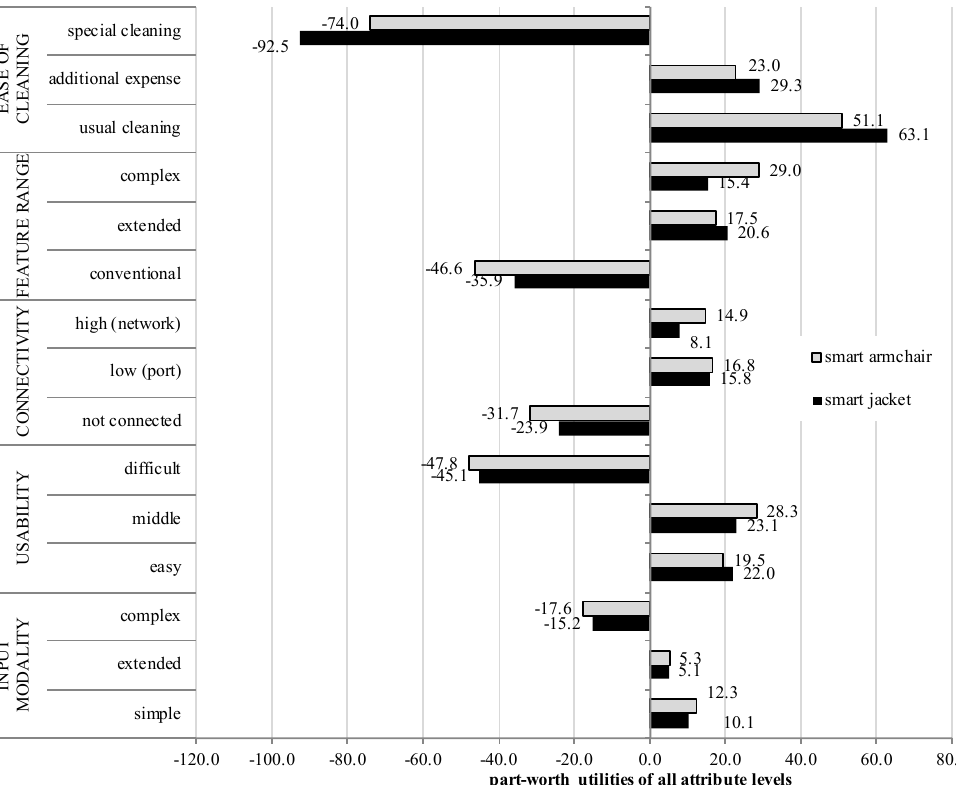
Figure 3. Part-worth utilities of all attribute levels for the smart jacket and the smart